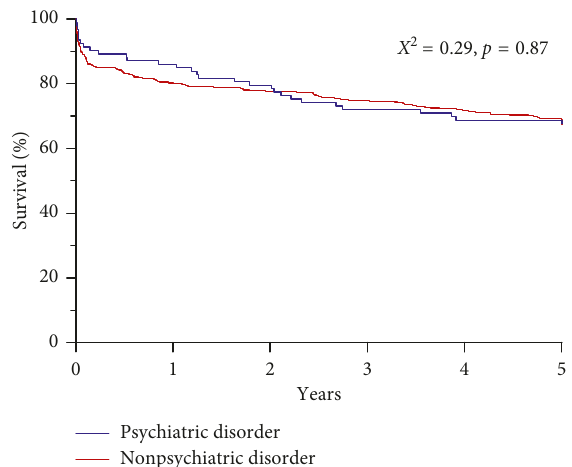
Figure 1: Kaplan–Meier survival analysis for patients with and without a premorbid psychiatric disorder.